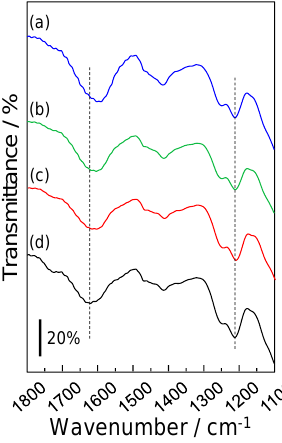
9 of 12 Figure 6. Molar ratios of acidic groups (sulfate and carboxylate groups) and metal ions. The amount of acid groups, such as the sulfate and carboxyl groups, in the fucoidan was determined by neutral- ization titration. The moles of the accumulated metal ions were estimated from the maximum-accu- mulated amount calculated from the assumed line in Figure 5. 3.4. Accumulative Mechanism of Metal Ions by F−SiNSi Composite Material The F−20 wt% SiNSi composite material could selectively accumulate the rare -earth and heavy metal ions. The selective accumulation of metal ions was evaluated by IR meas- urements. Figure 7 shows the IR spectra of (a) Y(III) ion-accumulated, (b) Cu(II) ion-accu- mulated, (c) Mg(II) ion-accumulated, and (d) non- accumulated F−20 wt% SiNSi composite materials. The non- accumulated F−20 wt% SiNSi composite material was prepared by im- mersion in an aqueous solution for 24 h . The F−20 wt% SiNSi composite material showe d absorption bands at 1212 cm −1 and 1620 cm −1 , attributed to the stretc hing vibration of S−O [28,29 ] and the symmetric stretching vibration of −COO − [28 – 30], respectively. The absorp- tion band of −COO − shifted to a lower wavenumber when the composite material accu- mulated the metal ions. The order of this shift value was Mg(II) < Cu(II) < Y(III) and de-